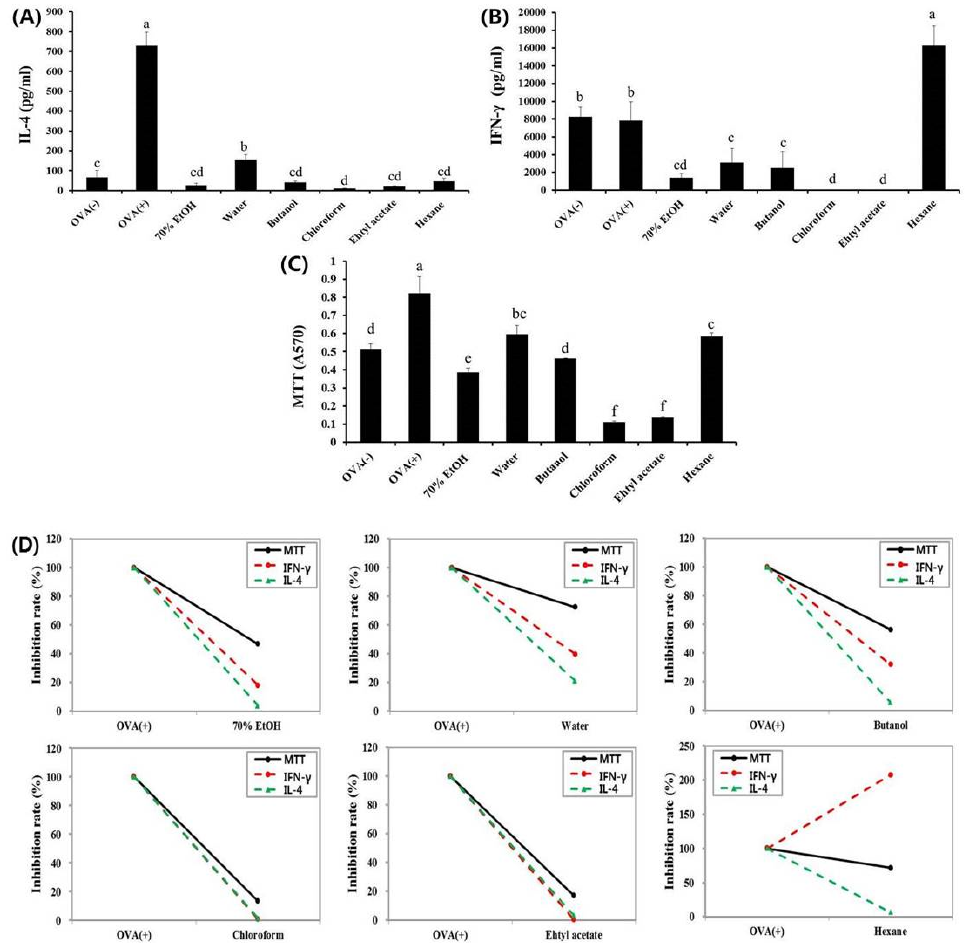
Figure 2. Effects of skullcap extract (ethanol, hexane, chloroform, ethyl acetate, butanol, and water) on ex vivo splenocytes from ovalbumin (OVA)-sensitized BALB/c mice. ( A ) Interleukin (IL)-4 and ( B ) Interferon (IFN)- γ were quantified by enzyme-linked immunosorbent assay (ELISA) using splenocytes; ( C ) Cell viability and cytotoxicity were measured by the 3-(4,5-dimethylthiazol-2-yl)-2,5-diphenyltetrazolium bromide (MTT) assay; ( D ) Inhibition rate (%). Values are presented as mean ± standard deviation (SD) ( n = 4 in each group). Data were analyzed by analysis of variance (ANOVA), followed by Duncan’s multiple-range test. Data are statistically different ( p < 0.05) among those columns with different symbols. The order of value is termed as order of alphabet.